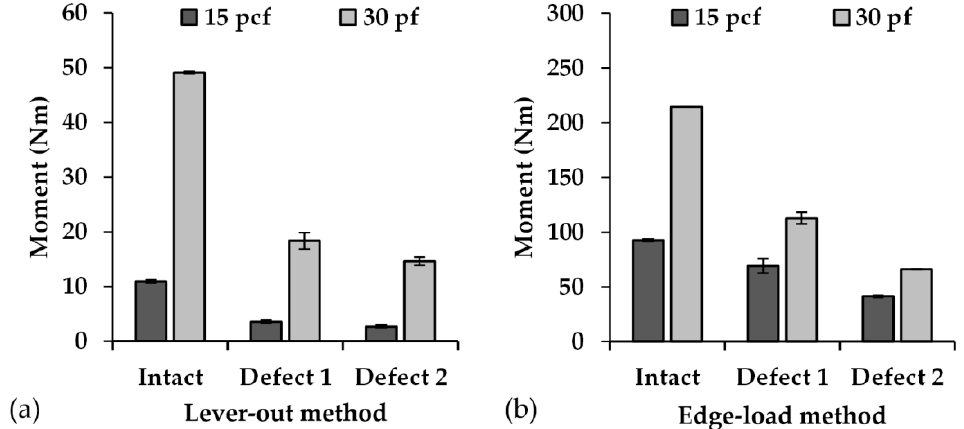
Figure 6. Comparisons of the determined moments of the acetabular cups with regard to the combination of cavity type and foam density for ( a ) the lever-out test method (Method 1) and ( b ) the edge-load test method (Method 2). The tilting moments are presented as mean value ( n = 3 ), and the error bars represent the SD. The intact cavity made of 30 pcf foam density tested with Method 2 is the only exception, where only one cup could be tested. For reasons of better visibility, the scaling of both graphs was adjusted to the determined values.